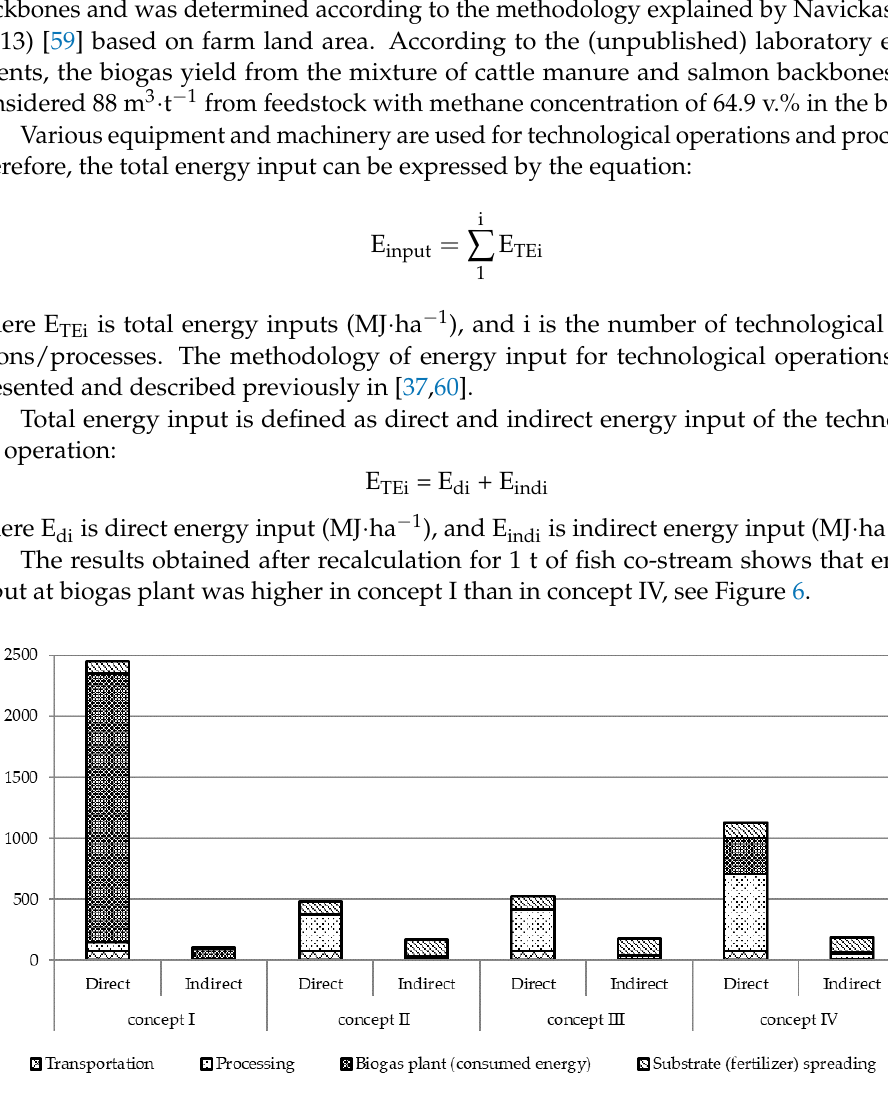
Figure 6. The direct and indirect energy input of zero-waste bio-refining of the fish co-stream. In concept I, the mass of the fish co-stream was estimated to be 2400 t per year